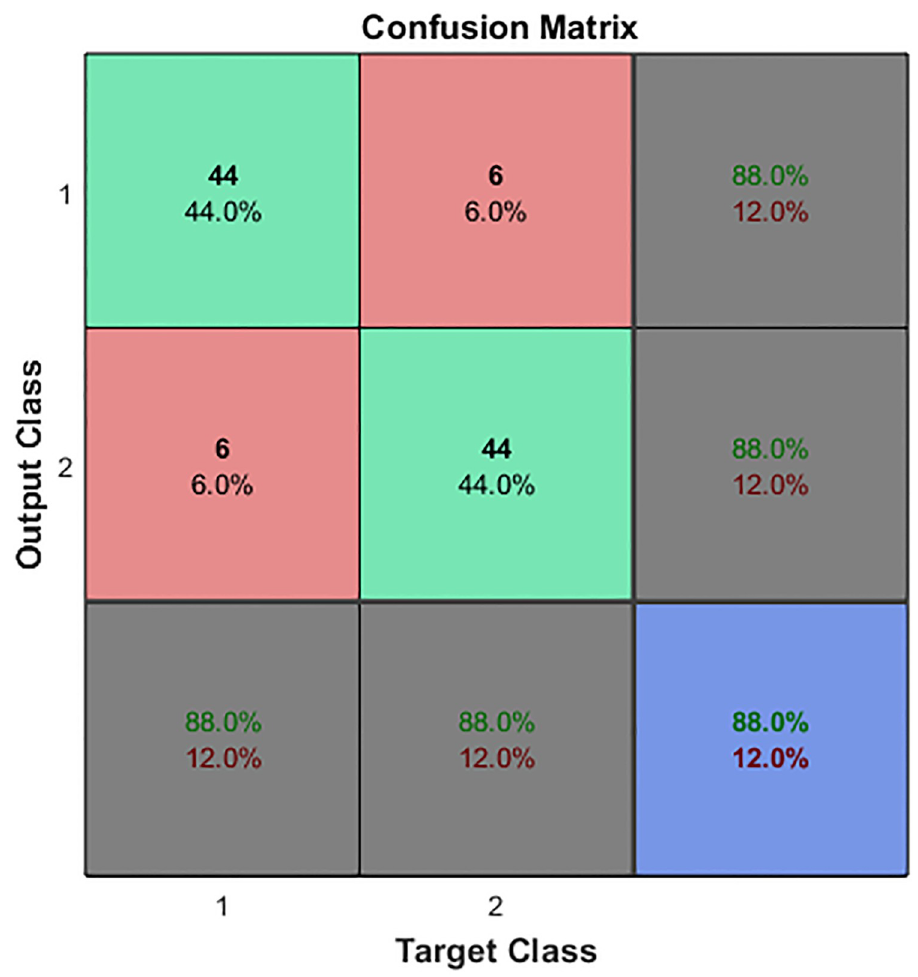
Fig 9. The classification result of test set by using the obtained